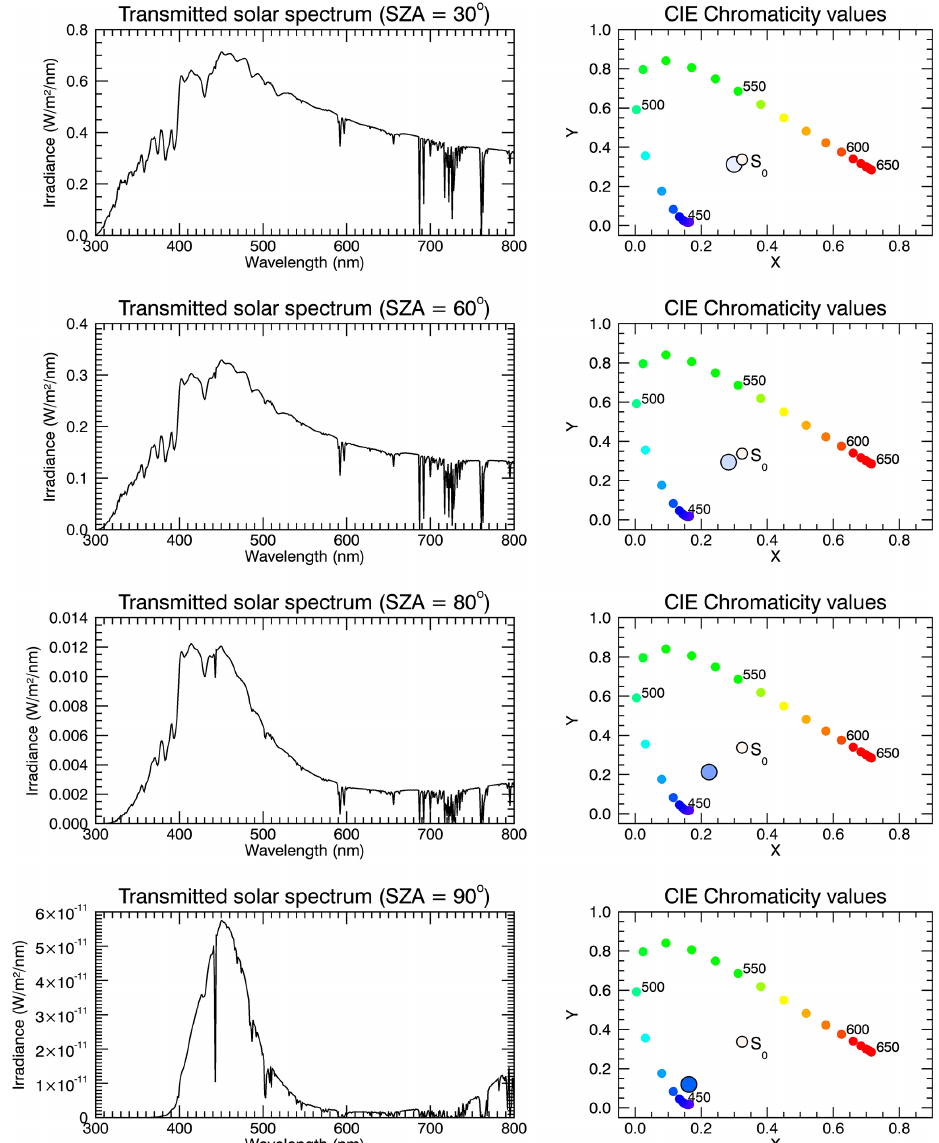
Figure 4. Simulated transmission spectra (left column) and CIE chromaticity plots (right column) for a ground-based observer looking directly into the sun and for SZAs of 30, 60, 80 and 90 ◦ (from top to bottom). The simulations include Rayleigh scattering, molecular absorption by all relevant species, and an additional aerosol layer with anomalous extinction and a vertical optical depth of τ = 1 (at 550nm), a distribution width of S = 1 . 05, a real part of the refractive index of 1.4 and a median radius of r m = 550nm. A blue sun can be reproduced with the assumptions made for all SZAs